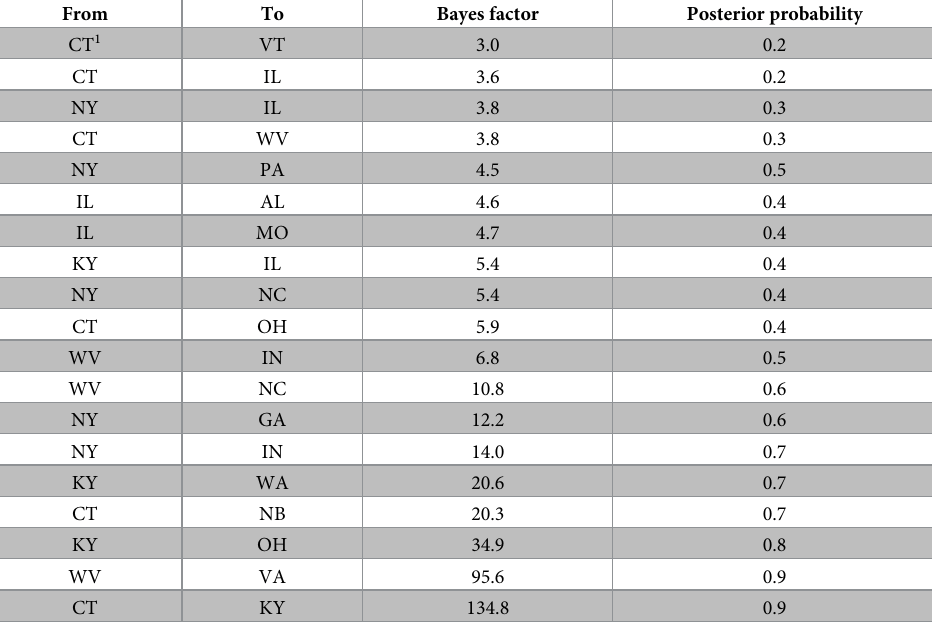
Table 2. Bayes factors of the location pairs with � 3 values and their respective posterior probability.